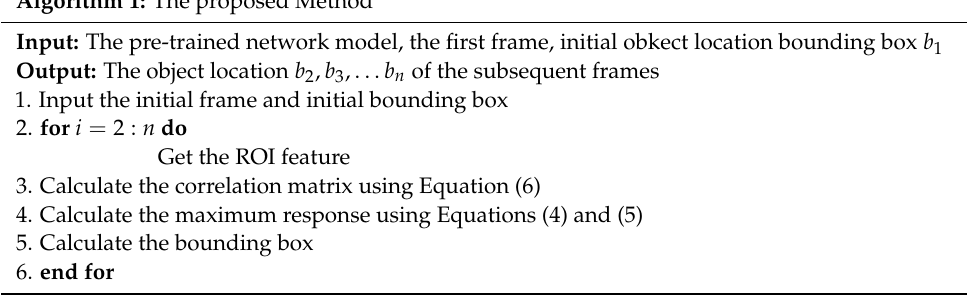
Algorithm 1: The proposed